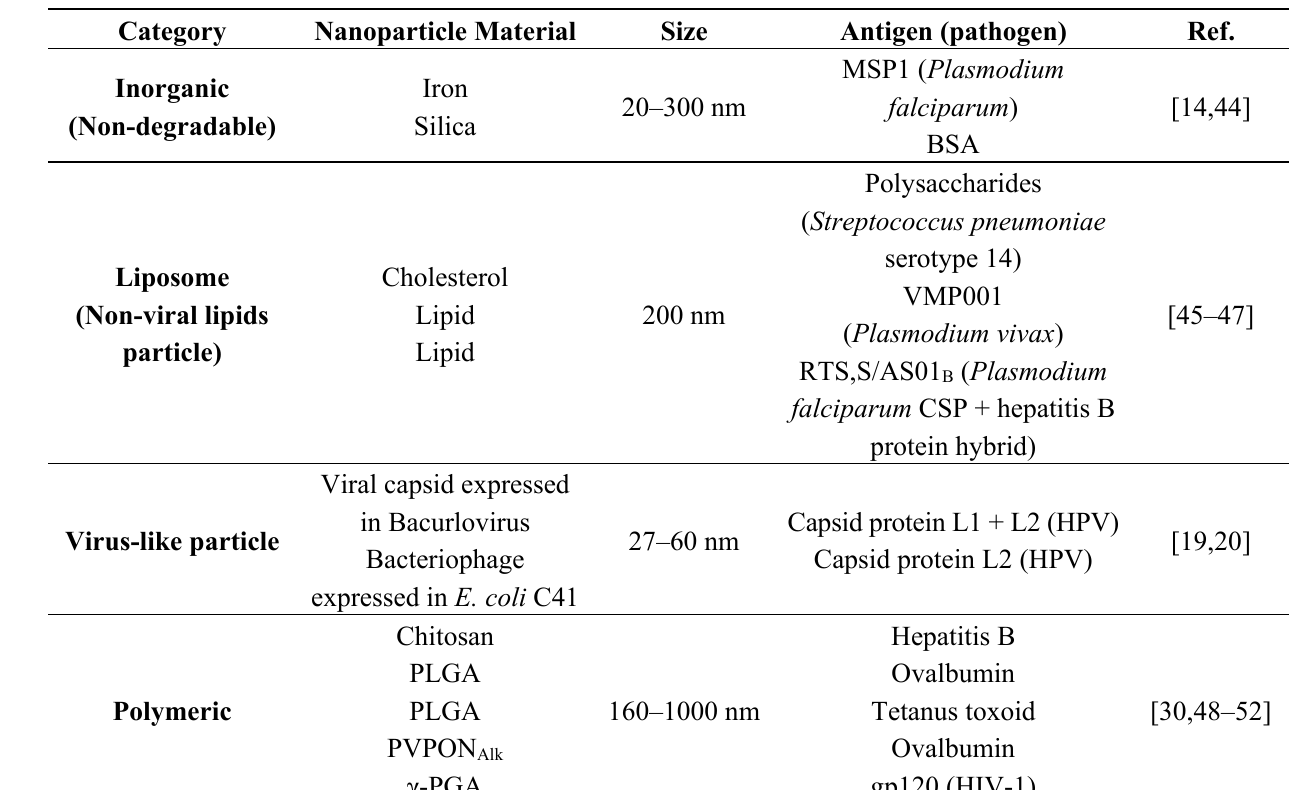
Table 2. Examples of various types of nanoparticles studied for antigen